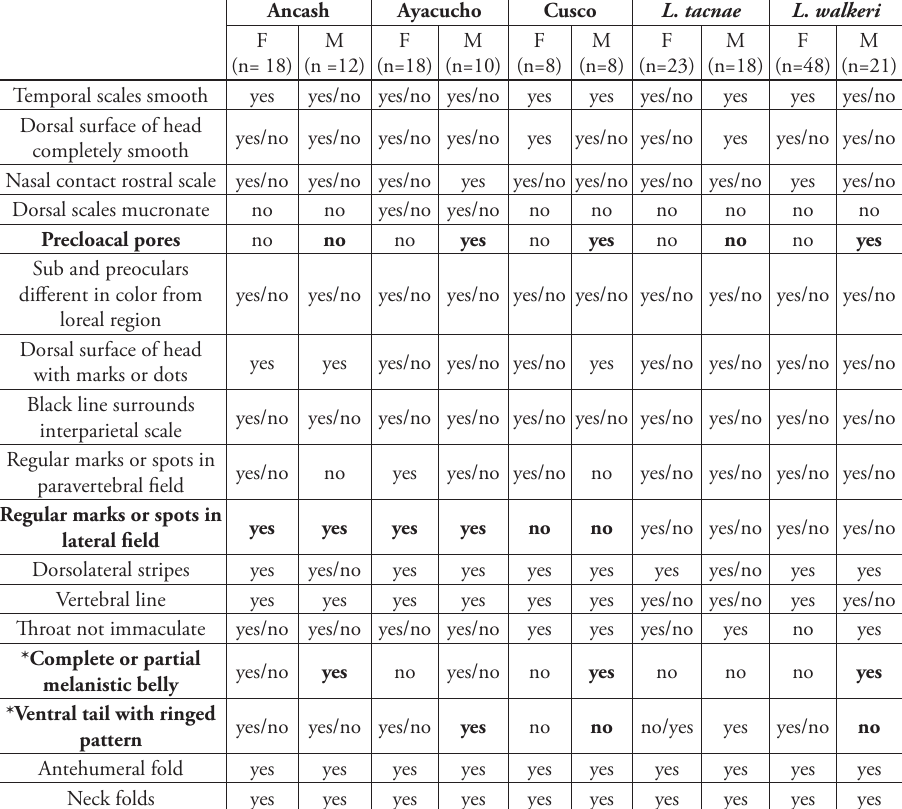
table 1. Binomial characters for females (F) and males (M) of focal populations of Liolaemus lizards sam- pled for this study. Character states useful for species discrimination are in bold, and states only assessed on adults are indicated with an asterisk.